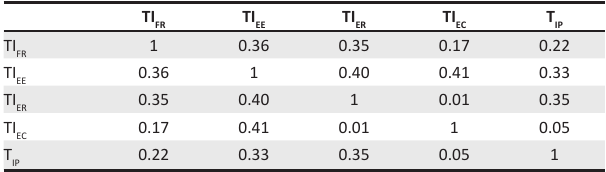
FIGURE 1: Correlation matrix for technology index components.